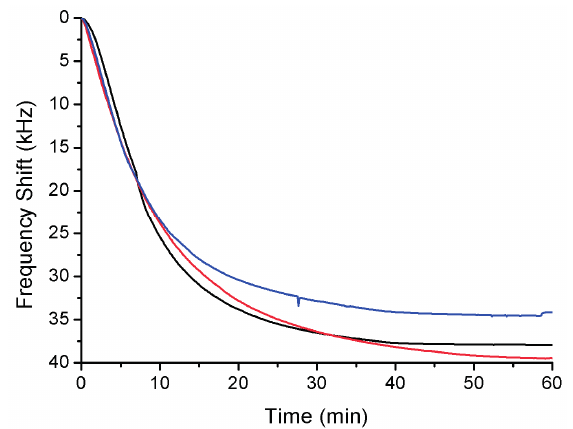
Figure 3. Frequency shift for three different immobilizations of the GAR antibody on the surface of SiO . 2